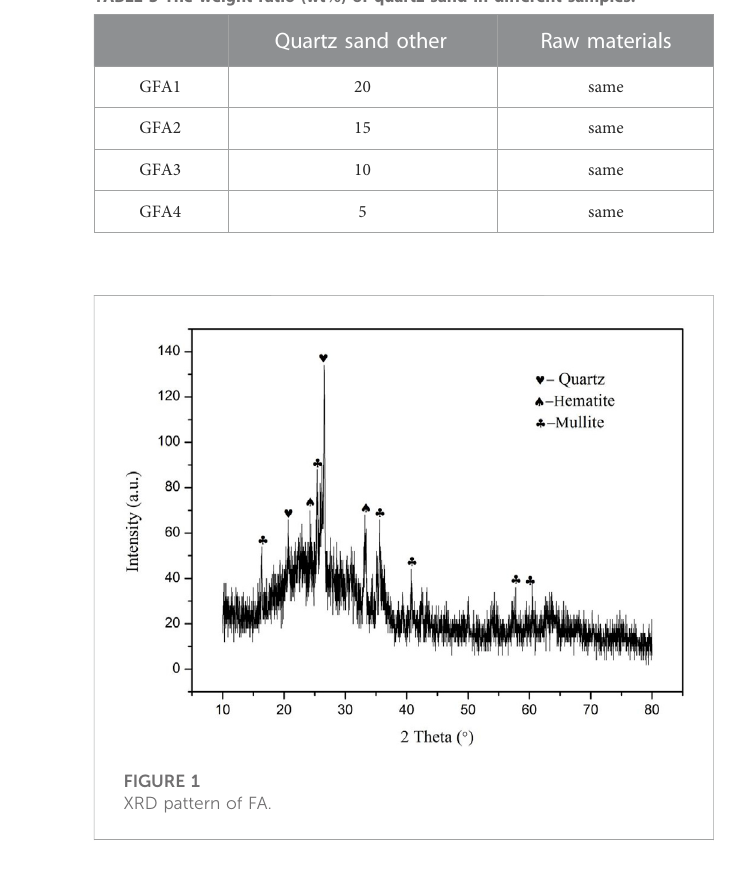
TABLE 3 The weight ratio (wt%) of quartz sand in different samples.